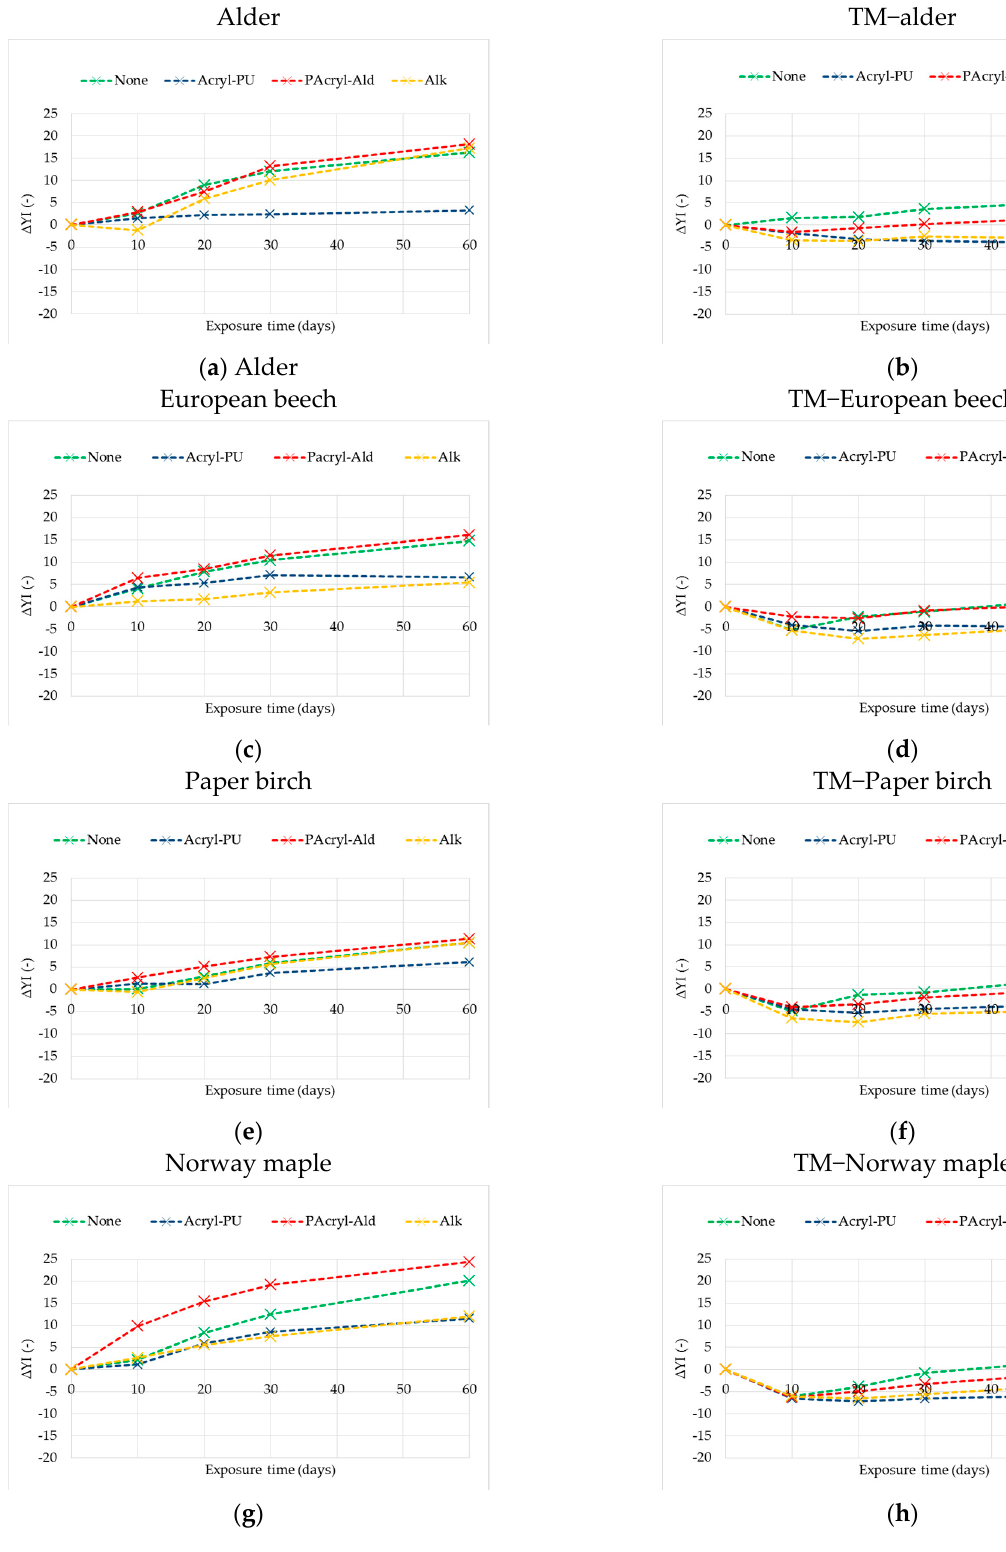
Figure 6. Variations in the difference in the yellowness index ∆ YI after exposure to indoor sunlight of coated and uncoated native ( a , c , e , g ), and thermally treated ( b , d , f , h ), wood for 60 days.